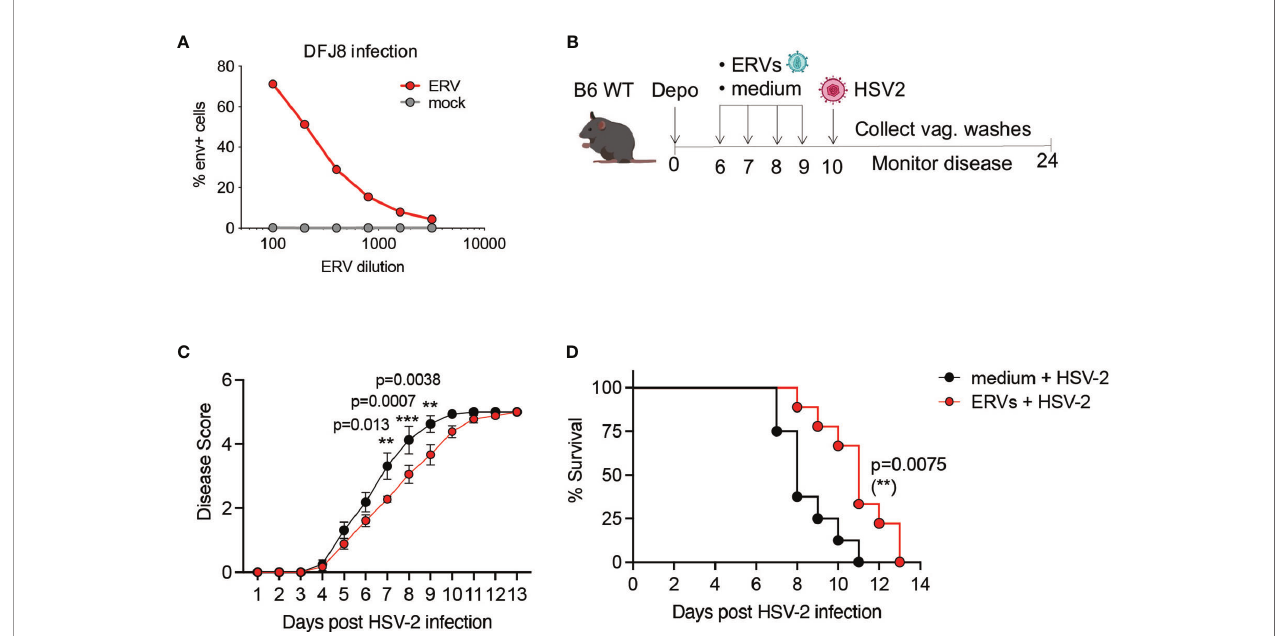
FIGURE 2 | Puri fi ed ERVs from Tlr7 -/- mice are suf fi cient to delay HSV-2 pathology in WT mice. (A) DFJ8 infection of puri fi ed ERVs compared to mock supernatant at the indicated dilutions measured by FACS using anti-ERV envelope antibody, gated on live cells. (B) Schematic of ERV pre-treatment followed by HSV-2 infection in WT B6 mice. Mice were pre-treated with puri fi ed ERVs (n=9) or medium (n=8) on the indicated days and infected intravaginally with 25,000 PFU of HSV-2 and monitored for disease (C) and survival (D) . The data are pooled from two independent experiments. Statistical signi fi cance was calculated using two-way ANOVA Sidak ’ s multiple comparisons test for disease score and Mantle-Cox test for survival. **p < 0.01; ***p <